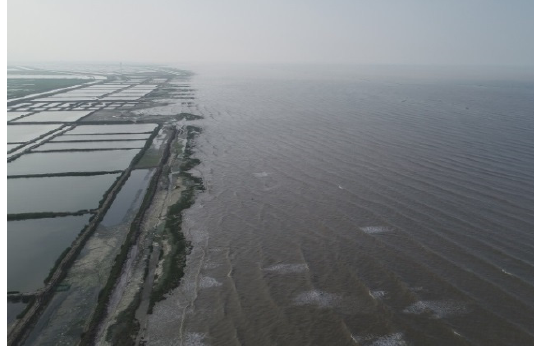
Figure 4. The eroding shoreline bound by shrimp-pond earth embankments and remnant salt marsh. UAV photo is looking northward and was taken on 28 June 2019. The location is shown in Figure 3 (camera A).